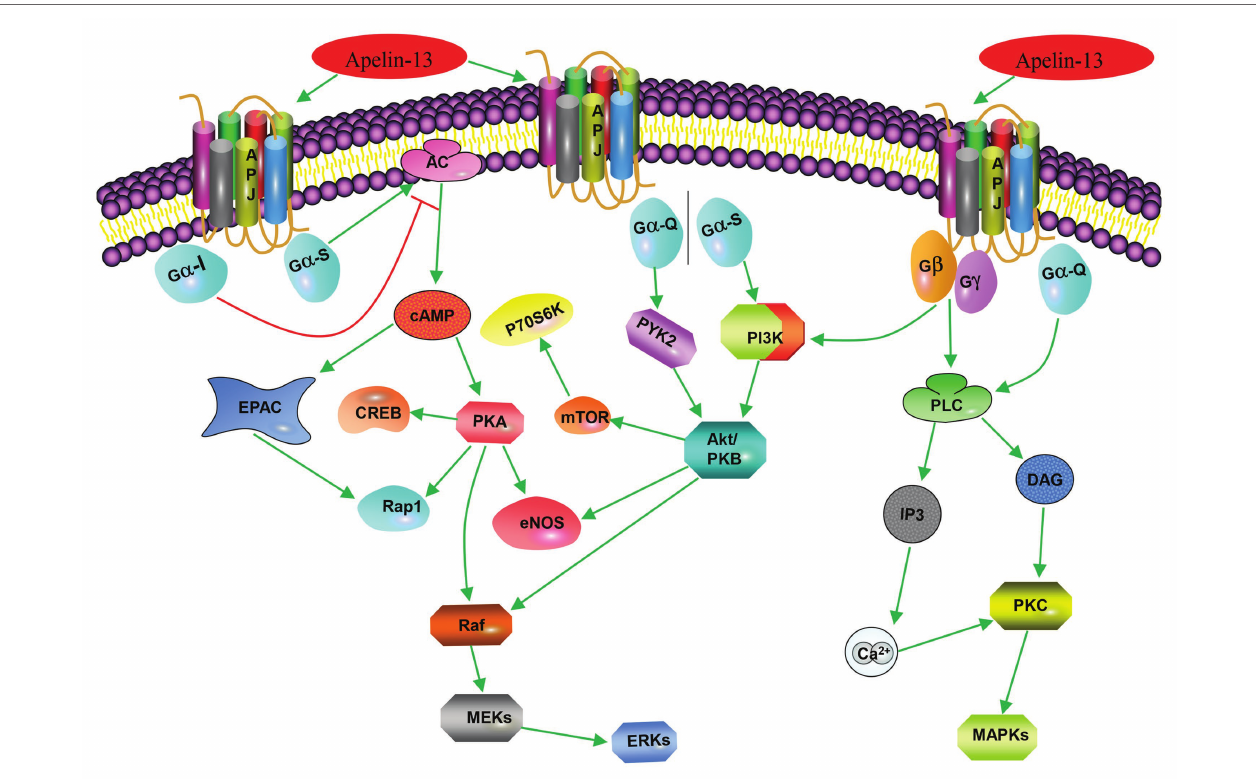
FIGURE 2 | Apelin-associated signaling pathways. Apelin-13 (in addition to apelin-17, apelin-36, and [pyr 1 ]-apelin-13) binds to APJ to couple G α i, inhibits forskolin (FSK)-induced cAMP generation, and blocks various biological effects produced by the protein kinase A (PKA) pathway; it (or apelin-36) binds to APJ-coupled Gio or Gq/11 to activate extracellular signal-regulated kinase 1/2 (ERK1/2) through protein kinase C (PKC) pathway; it (or [pyr 1 ]-apelin-13) activates phosphorylation of ribosomal protein S6 kinase (p70S6) through the PI3K/Akt and ERK1/2 signaling pathways. Apelin-13 promotes cell proliferation, division, migration, and metabolic function through the PI3K/Akt signaling pathway or MAPK pathway; and it (or apelin-12) stimulates endothelial nitric oxide synthase (eNOS) through the protein kinase B (PKB)